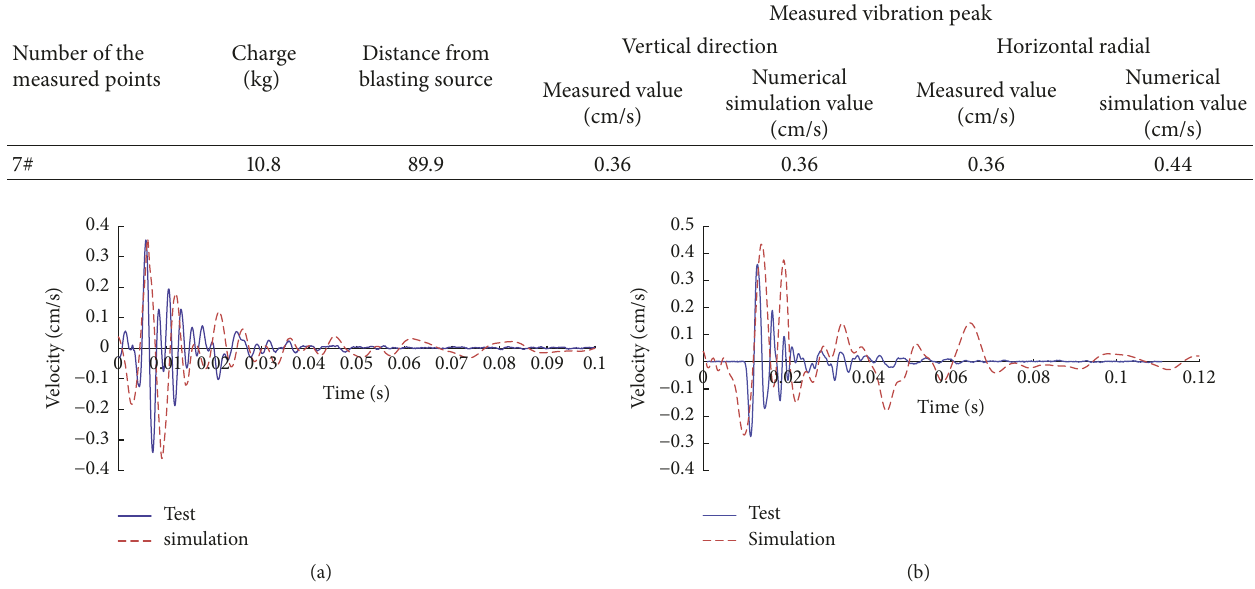
Table 1: The comparison of vibration peak between the measured and numerical simulation results in Fengning site test.